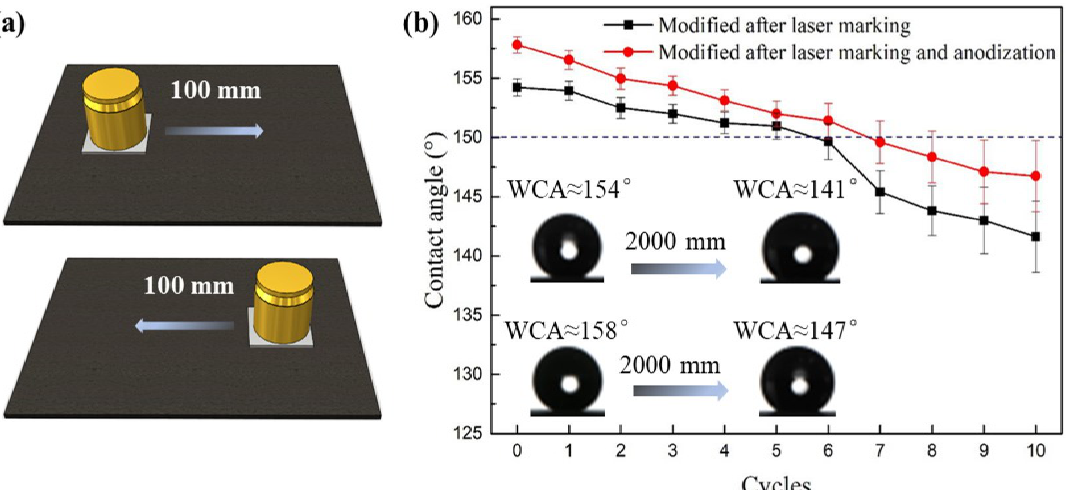
Figure 8. Mechanical stability test of the superhydrophobic surface. ( a ) the testing scheme, ( b ) WCA value after different testing cycles. In each testing cycle, the sample with 100 g weight is uniformly pushed 100 mm forward and pulled 100 mm back to the original